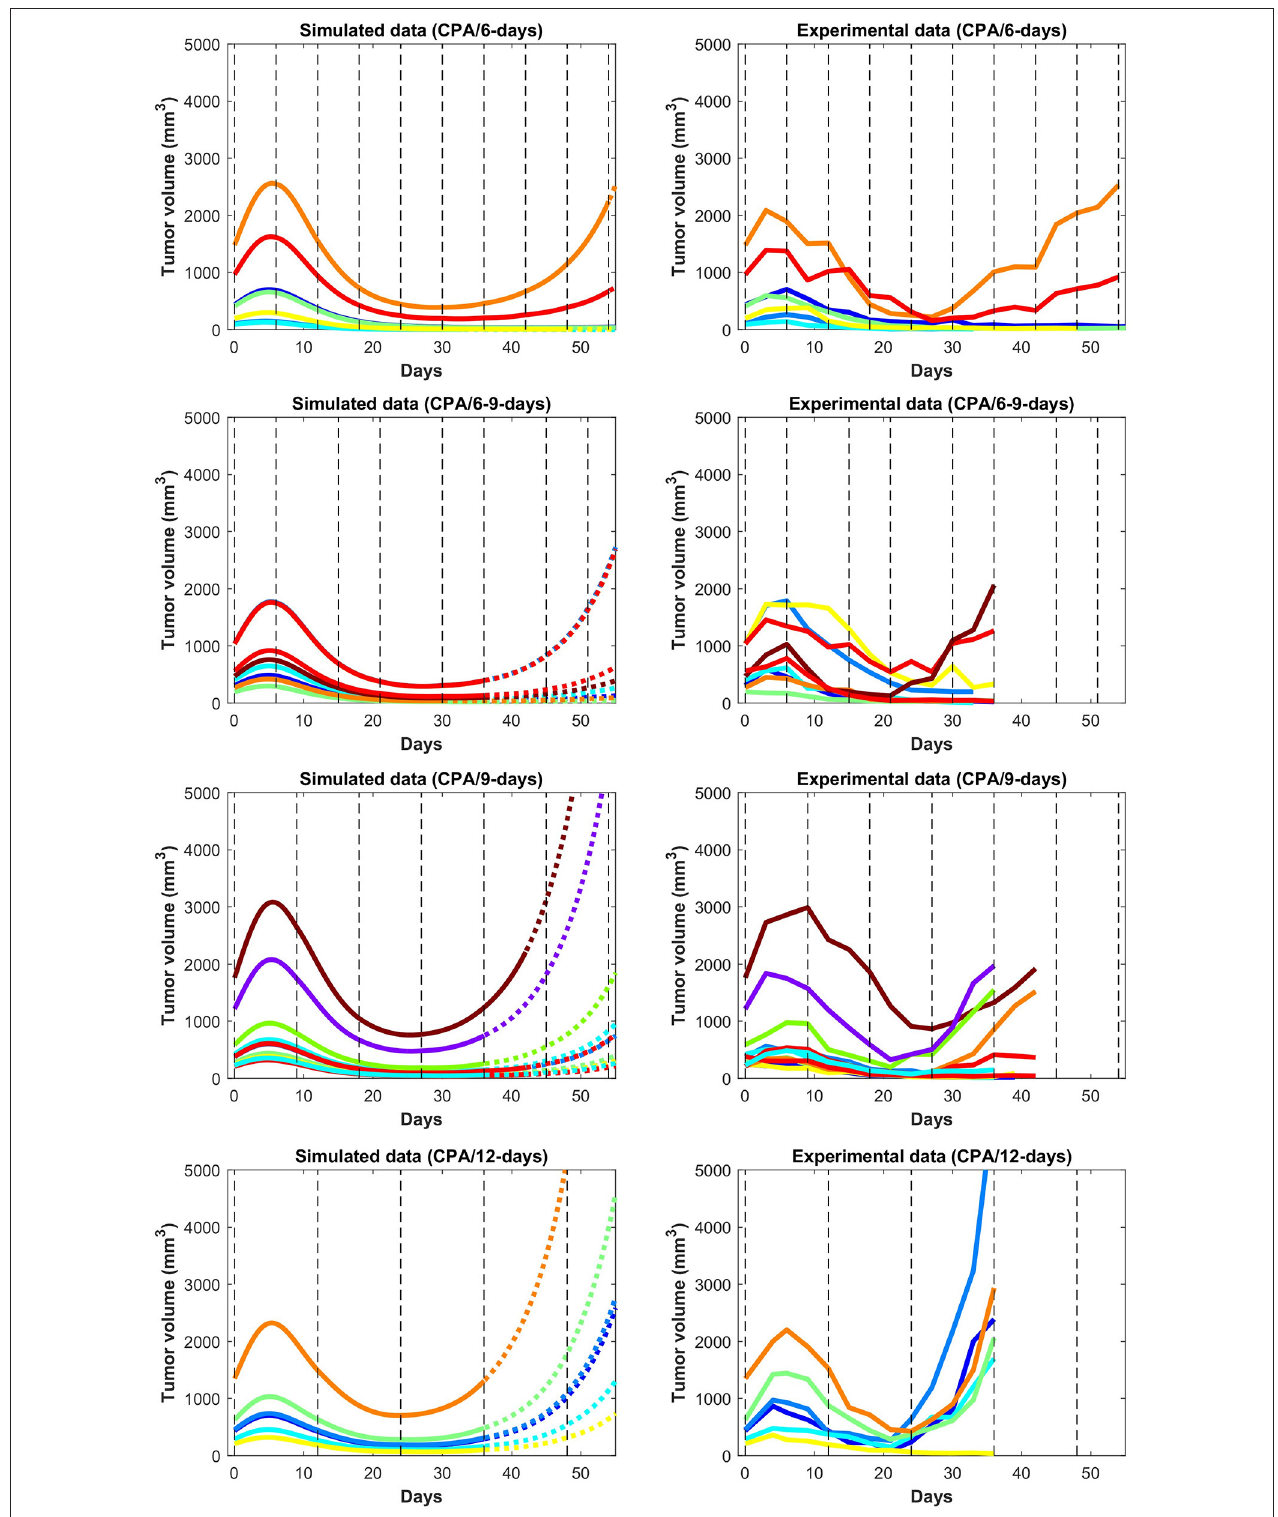
FIGURE 4 | Simulated and experimental growth curves for the scenarios CPA/6-days, CPA/6-9-days, CPA/9-days, and CPA/12-days. Solid lines represent fitted data; dotted lines represent predicted growth curves extrapolated from the model.